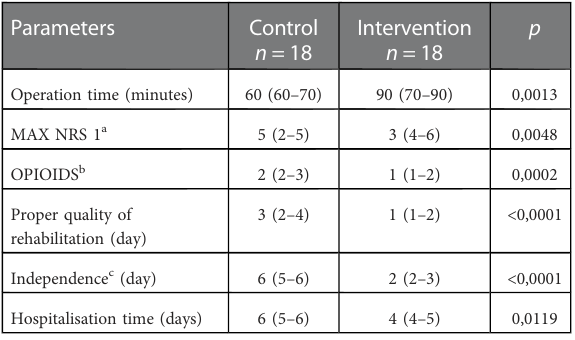
TABLE 2 Surgical data from patients in both